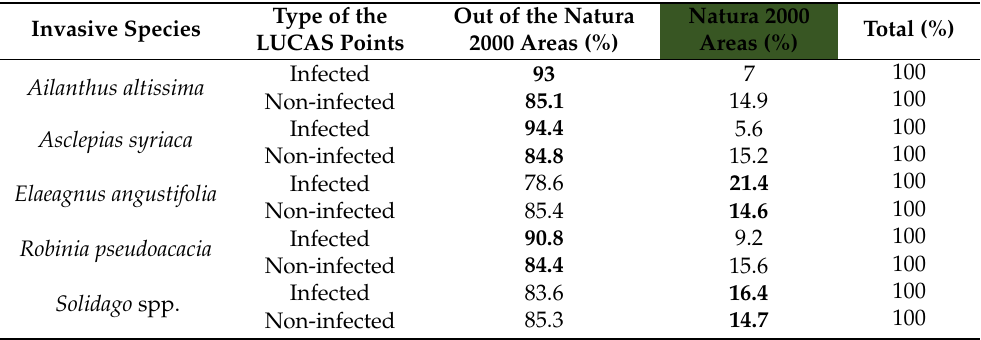
Table 3. The spatial distribution of LUCAS points infected and non-infected by the invasive plants, inside and outside Natura 2000 areas in Hungary (The bold numbers show the results where the proportion of the given invasion plant (LUCAS point) is higher (overrepresented) than the proportion of non-infected LUCAS points within the given unit). Type of the Out of the Natura LUCAS Points 2000 Areas (%) Areas (%) Ailanthus